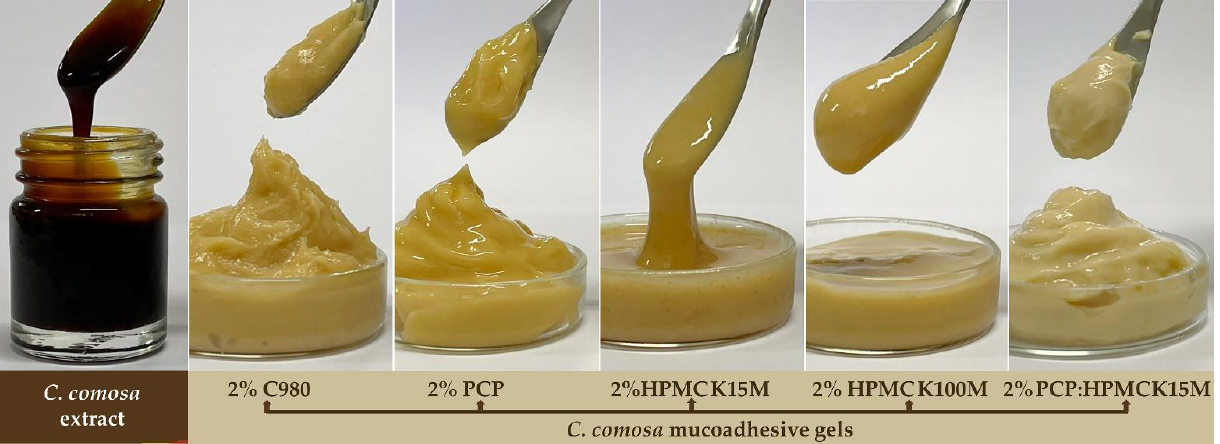
Figure 2. Macroscopic characteristics of C. comosa extract and C. comosa mucoadhesive gels prepared from various mucoadhesive polymers.